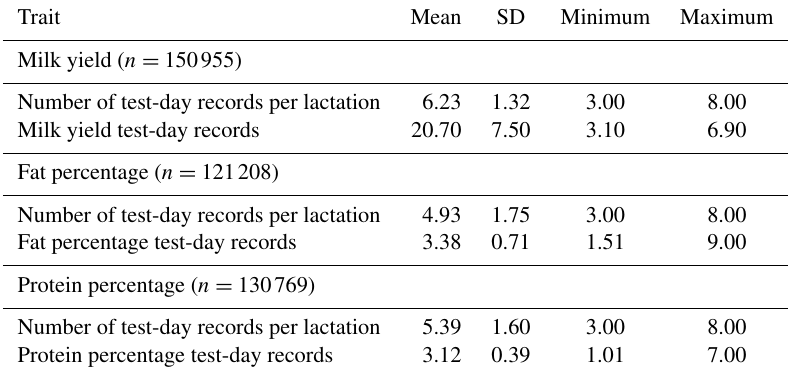
Table 1. Descriptive statistics. Trait Mean SD